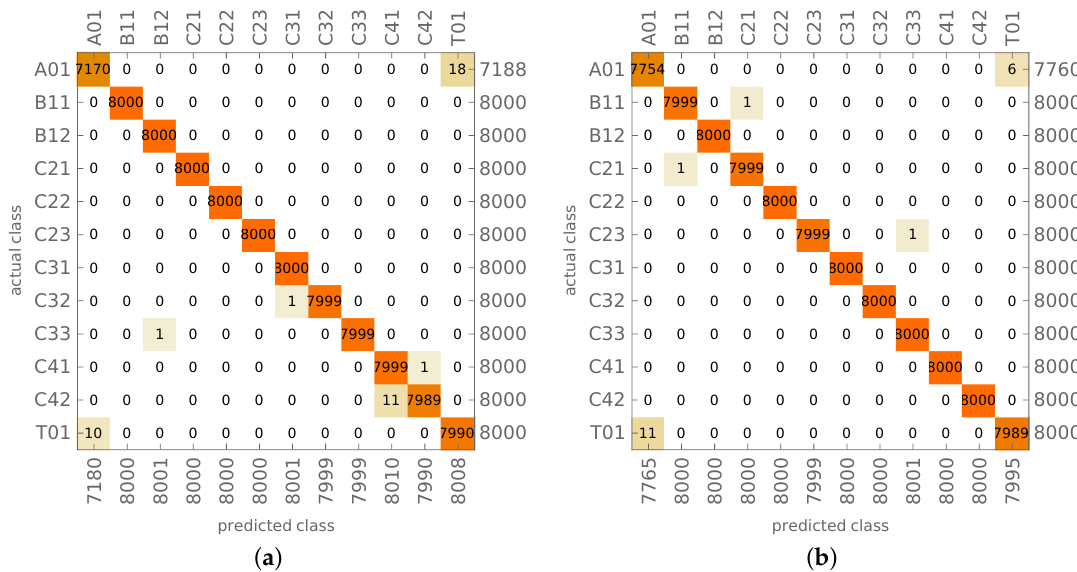
Figure 7. The results of CNN- N mode shapes identification using noisy data ( σ 1 = 0.0005 and σ 2 = 0.25): ( a ) learning, ( b )